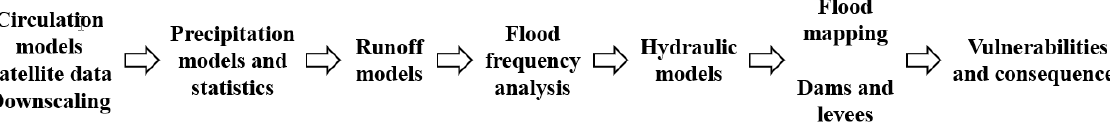
Figure 2. Sequence of data and analysis for comprehensive flood risk assessment.